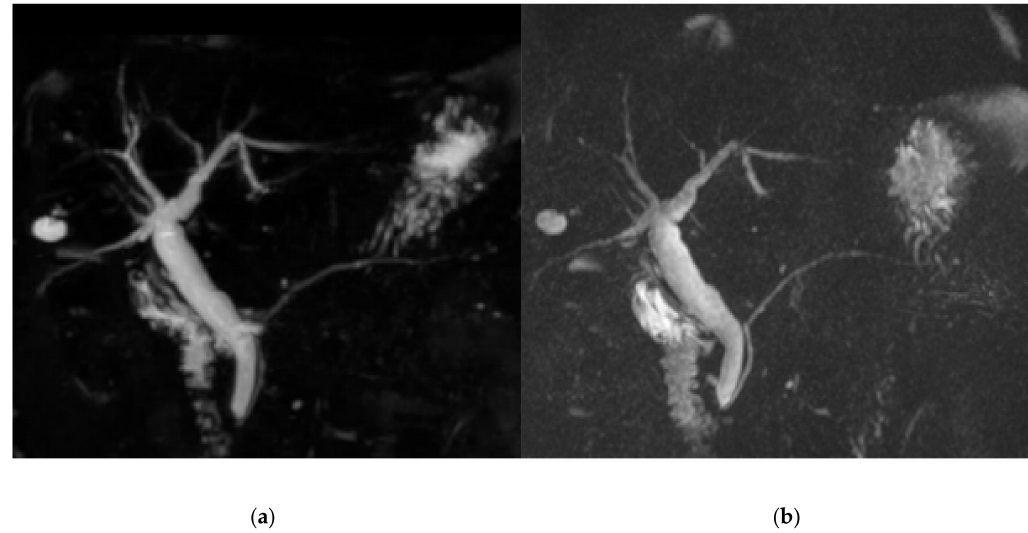
Figure 3. An 80-year-old female who had a history of pancreatitis. Image degradation by artifacts (5 vs. 5, BH-CS-MRCP vs. BH-GRASE-MRCP, respectively) and overall image quality (5 vs. 5) were comparable between BH-CS-MRCP ( a ) BH-GRASE-